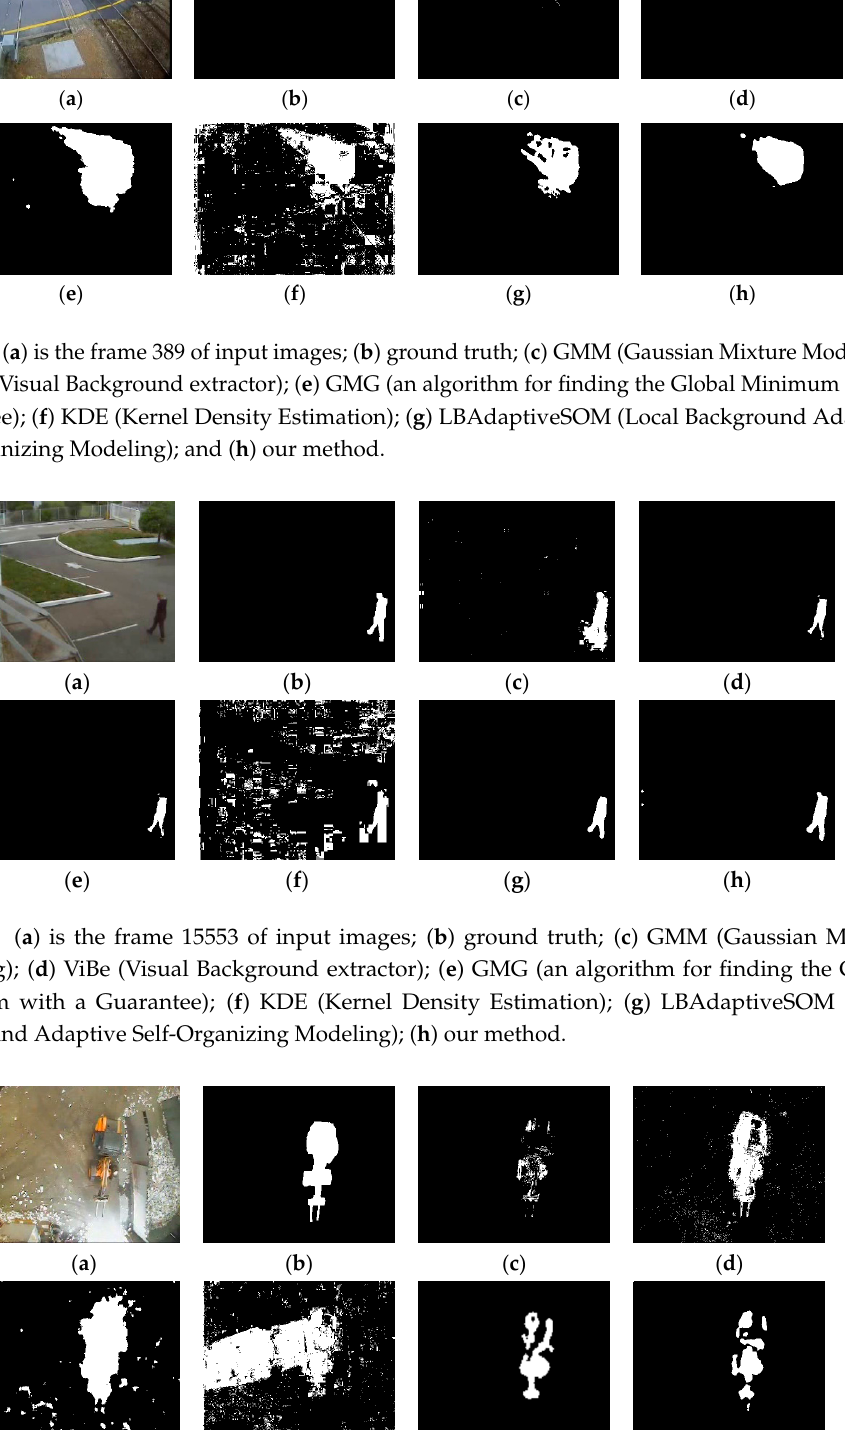
Minimum with a Guarantee); ( f ) KDE (Kernel Density Estimation); ( g ) LBAdaptiveSOM (Local